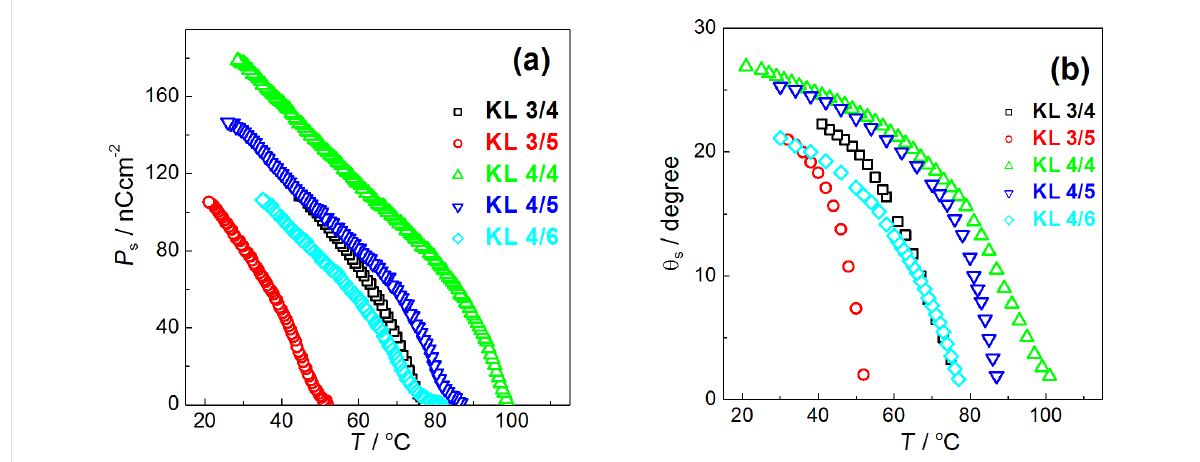
Figure 2: Temperature dependencies of spontaneous polarization P s , (a) and tilt angle of molecules θ s , measured optically (b) for KL 3/4 (black rectangle), KL 3/5 (red circle), KL 4/4 (green triangle), KL 4/5 (blue triangle) and KL 4/6 (cyan diamond) as indicated.